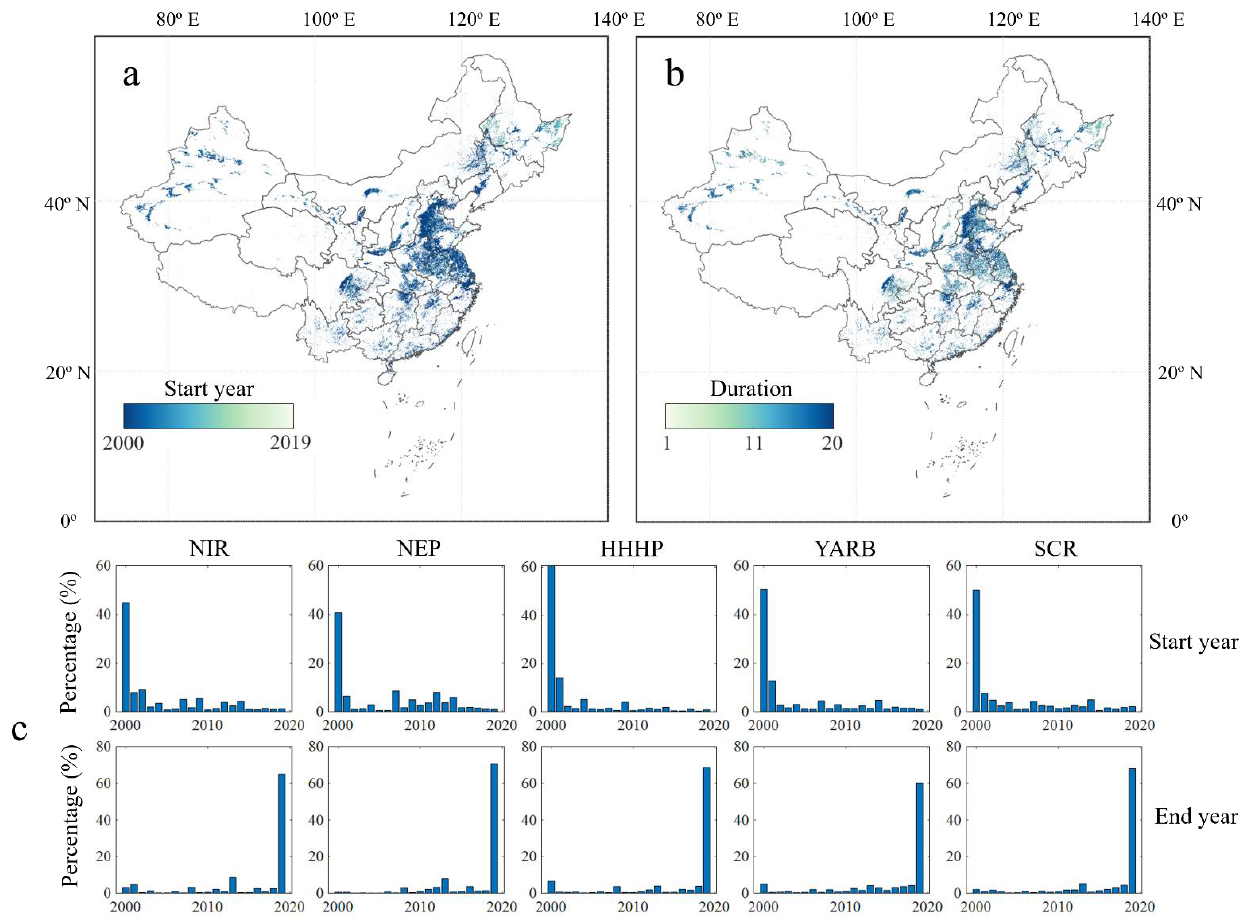
Figure 8. The summary of irrigated cropland changes on time information in China during 2000–2019: ( a ) the start year distribution of irrigated cropland at 30 arcsec resolution, ( b ) period duration distribution of irrigated cropland at 30 arcsec resolution, and ( c ) start and end years’ proportion in five large